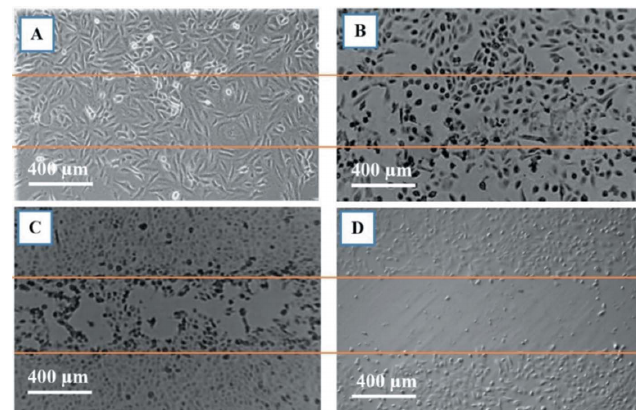
Figure 10 Human prostate cancer DU145 monolayer cells 24 h after being exposed to 500 m m SBB. The radiation fields are marked between orange lines. (A) 50 Gy, (B) 100 Gy, (C) 500 Gy and (D) 1000 Gy.